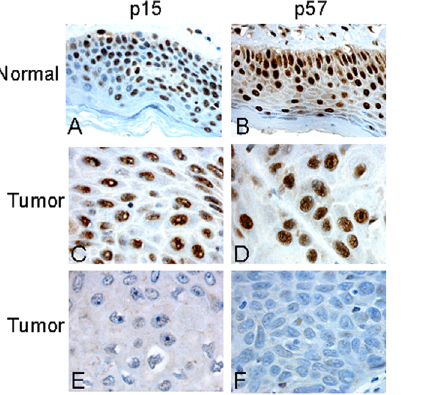
Figure 1. Immunohistochemical staining of p15 INK4b and p57 KIP2 protein in vulvar squamous epithelium. High nuclear expression of p15 INK4b (A) and p57 KIP2 (B) in normal vulvar epithelium. High nuclear expression of p15 INK4b (C) and p57 KIP2 (D) and low nuclear expression of p15 INK4b (E) and p57 KIP2 (F) in vulvar carcinomas.